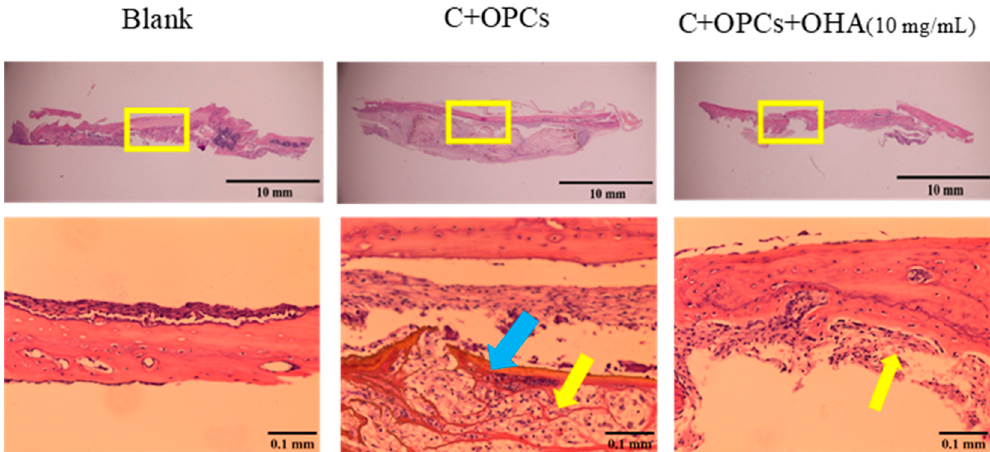
Figure 12. Histological images of control (Blank), collagen + OPC, and collagen + OPC + OHA scaffolds implanted on a skull defect captured after 1 week (upper panel). Enlarged images of the area within the yellow squares in the upper panels are shown in the lower panels (yellow arrows indicate the formation of new blood vessels, and the blue arrow indicates a scaffold).